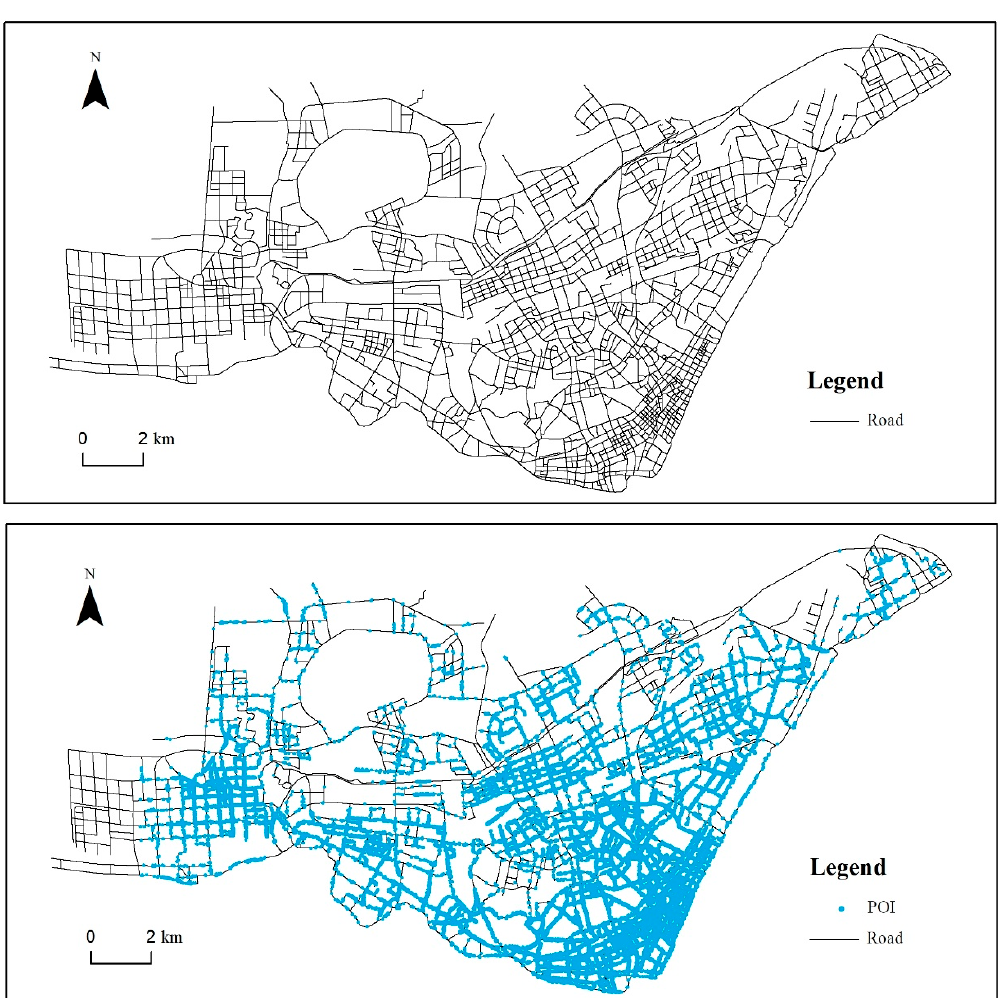
Figure 1. Original road network of the Hankou district and the distribution of POIs inside the road buffer.